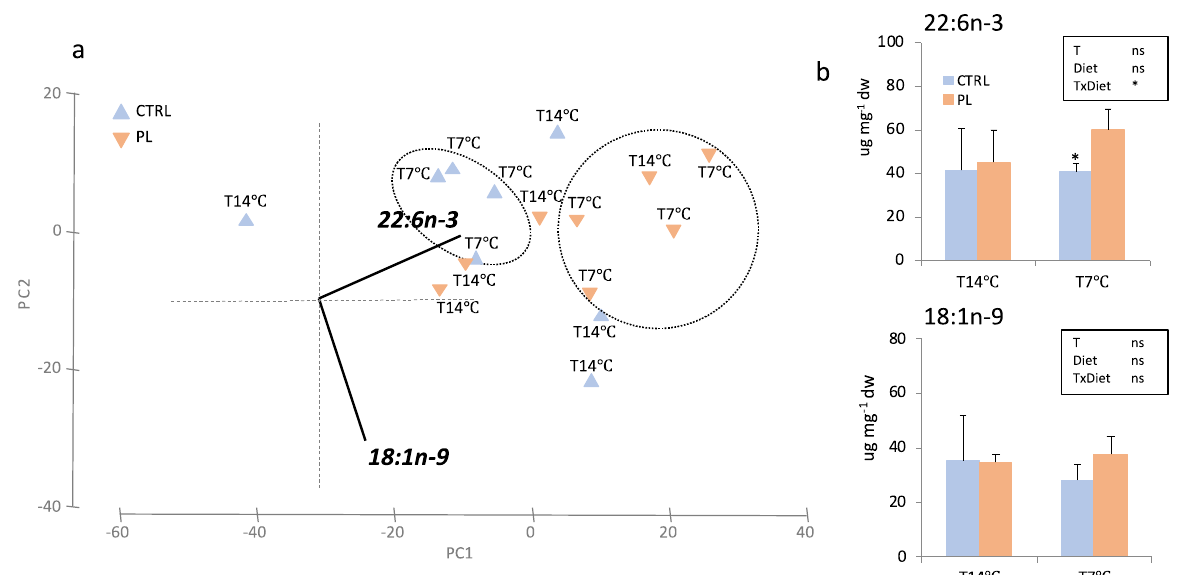
Figure 4. Hepatic FA amounts in animals fed with the control (CTRL, blue) or PL-enriched (PL, orange) diets. ( a ) Principal component analysis (PCA) plot based on FA composition (in µg FA mg dw − 1 ); ( b ) hepatic content of FA significantly correlated with PC1: 16:0 and 18:1n-9; and PC2: 18:1n-9. Data were expressed as mean ± SD ( n = 4). Results of two-way ANOVA are presented in the square (T=temperature; diet=dietary treatment). Asterisk above bars indicates significant differences between temperature treatments (t-test; p < 0.05). * p < 0.05; ** p < 0.01; *** p < 0.001.